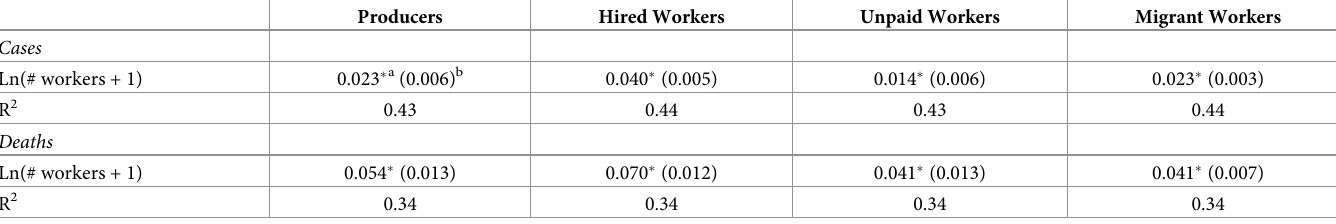
Table 2. Relationship between cumulative county COVID-19 incidence rate and number of agricultural workers. Producers Hired Workers Unpaid Workers Migrant